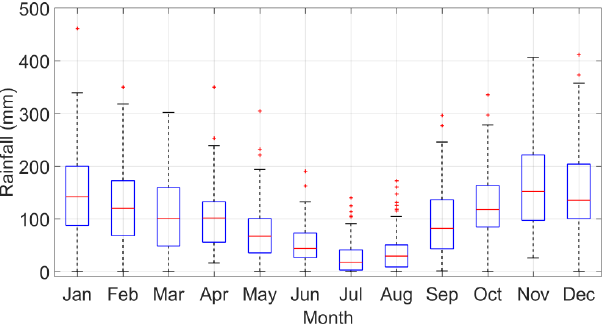
Figure 2. Box plots of monthly rainfall depths recorded at the Gioi Cilento weather station